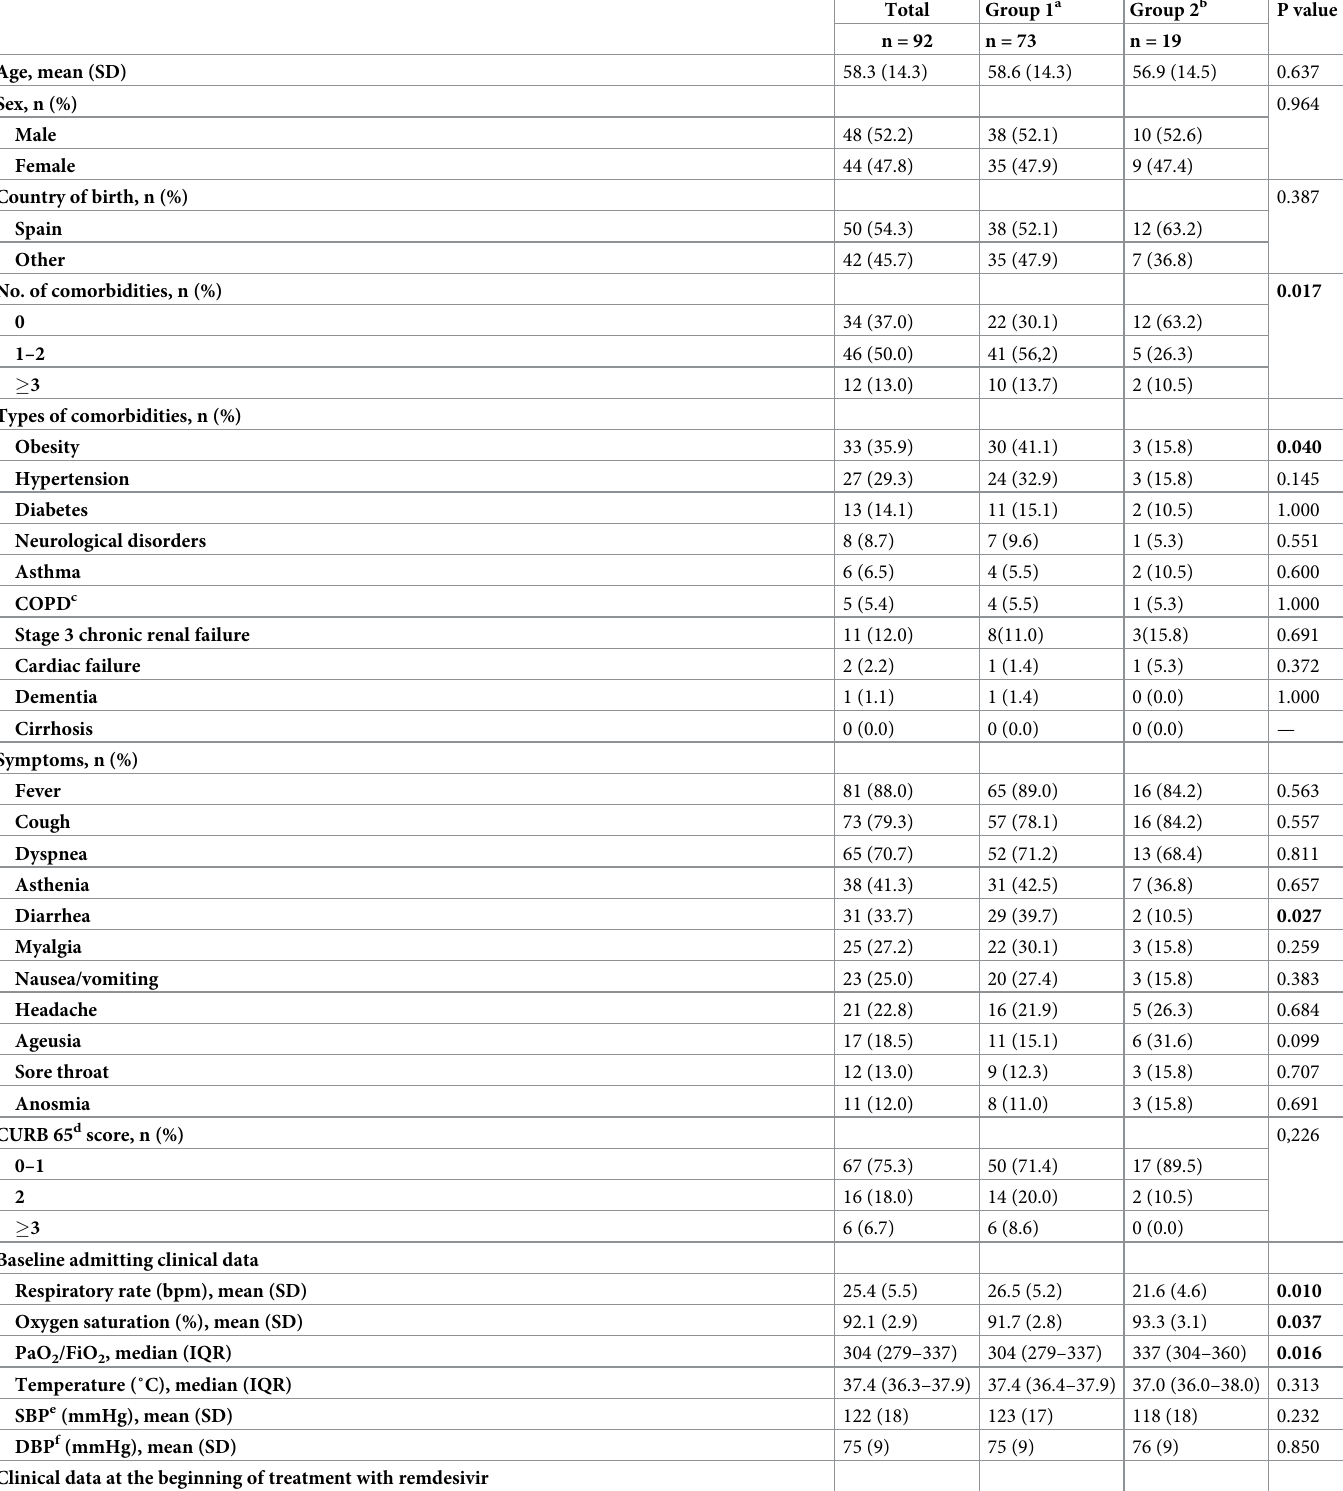
Table 1. Patients’ demographic and clinical